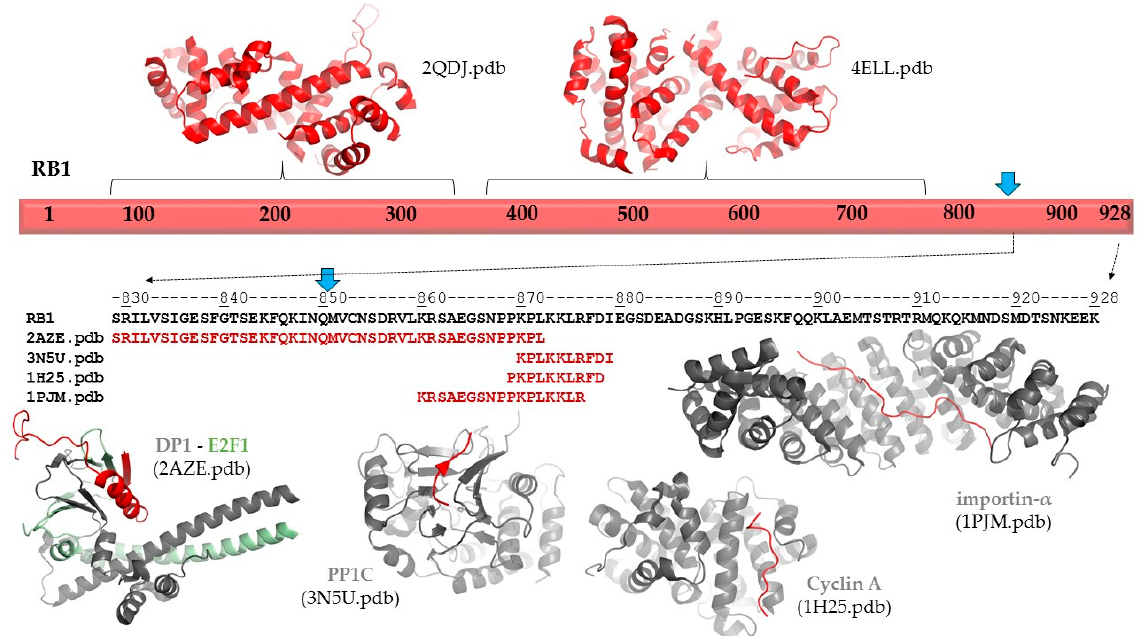
Figure 3. Structure and interactions of RB1. Schematic representation of the full-length RB1 protein is shown. The structures of the N-terminal and central regions are represented, and the protein–protein interactions of the C-terminal region are also shown based on structural data. The sequence of the C-terminal of region of RB1 is shown by black color. Blue arrows show the position of the p.Gln850Ter mutation. The sequences that are involved in protein–protein interactions are shown for each coordinate file; these regions are also highlighted in red in the complex structures.